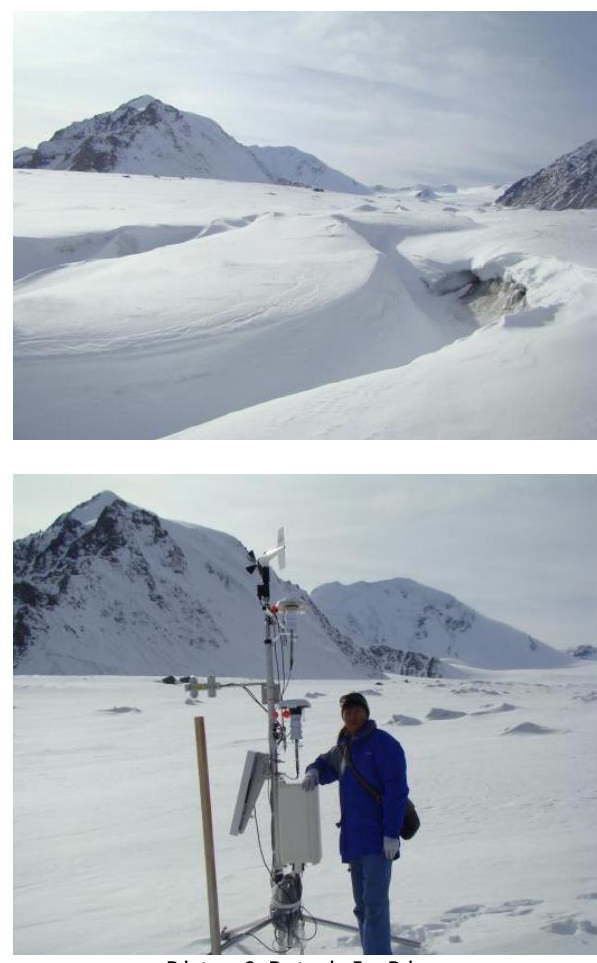
Picture 2. Potanin Ice